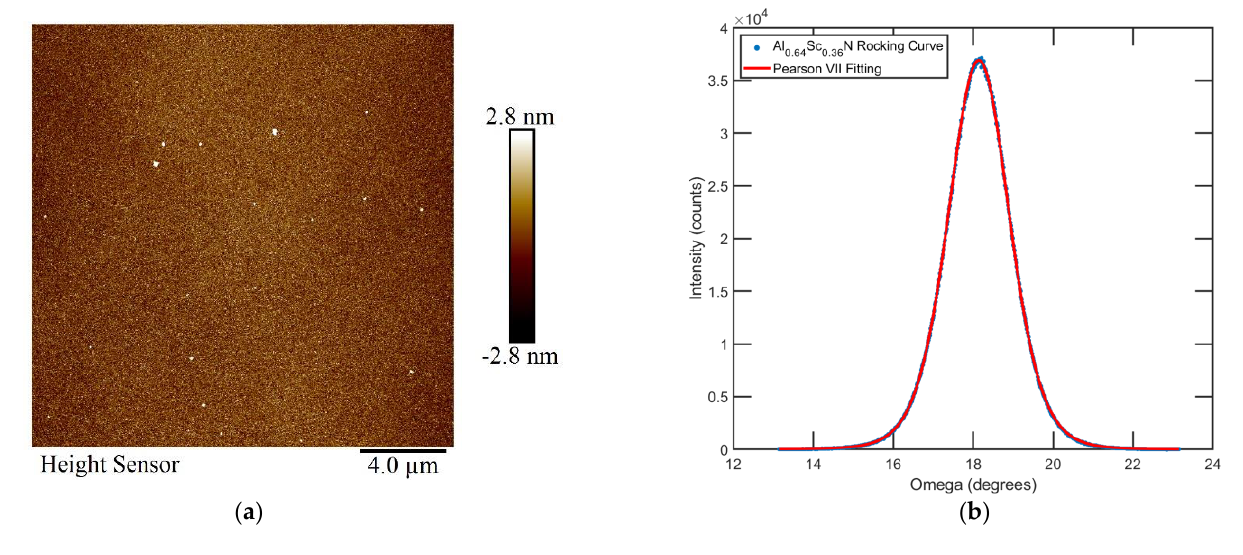
Figure 1. ( a ) AFM of the Al 0.64 Sc 0.36 N Film. ( b ) Rocking curve measurement (Omega Scan) of an Al 0.64 Sc 0.36 N film.